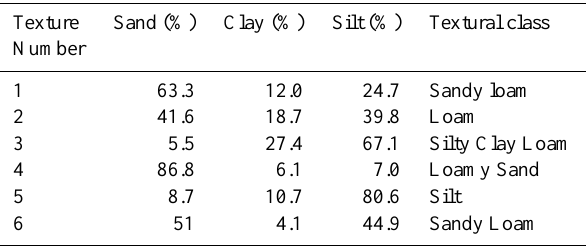
Table 1. Texture points randomly selected from the USDA textural triangle (Soil Survey Division Staff, 1993) and used as initial soil texture in all the model